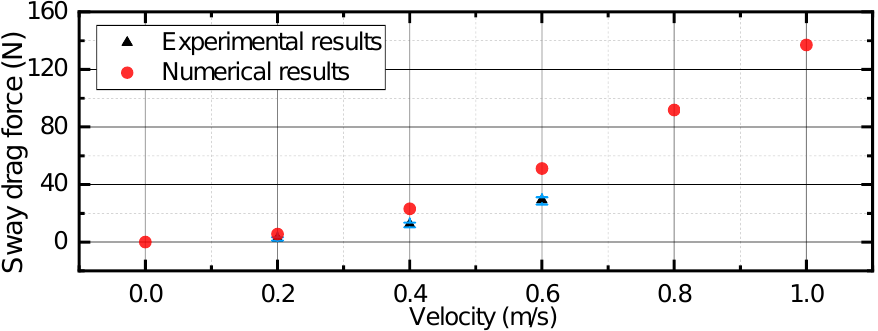
Figure 14. Comparison of sway force between the numerical and experimental results. Table 2. Table to test captions and labels. Damping